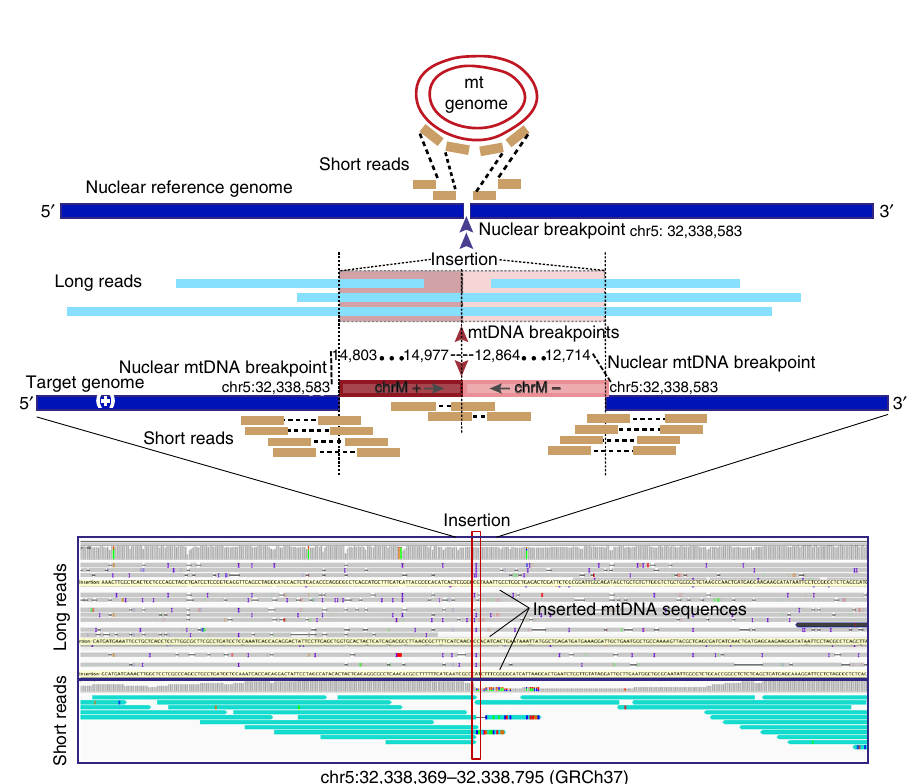
Fig. 5 Characteristics of mega-NUMTs. a Model showing the formation of mega-NUMTs and our strategy for their detection in whole genome sequence data. OH , origins of heavy-strand replication; OL , origins of light-strand replication. b Combined box and swarm plots show the estimated number of copies of the mtDNA-derived fragment within the NUMT in seven families. The middle “ box ” represents the median, lower and upper quartile of the data. The upper and lower whiskers represent the data outside the middle 50%. The dots represent the informative variants included in the mixed haplotype (Methods, Supplementary Table 4). c Modelling of the estimated variant allelic fraction for a NUMT at different true mtDNA sequencing depths. Modelling was based on whole genome nuclear sequencing (WGS) depths seen in our dataset (35×, 40×, 45× and 50×), and the corresponding variant fraction based on the number of copies of mtDNA-derived fragment within the NUMT. 95% con fi dent intervals are shown for one copy and 20 copies. d Detected variant allelic fraction for each of the seven families related to the true mtDNA per-base sequence depth. Upper and lower symbols show the trend of variant allelic fraction estimated from WGS depth 50× with 20 copies of mtDNA-derived fragments and WGS depth 35× with 1 copy of mtDNA-derived fragment.